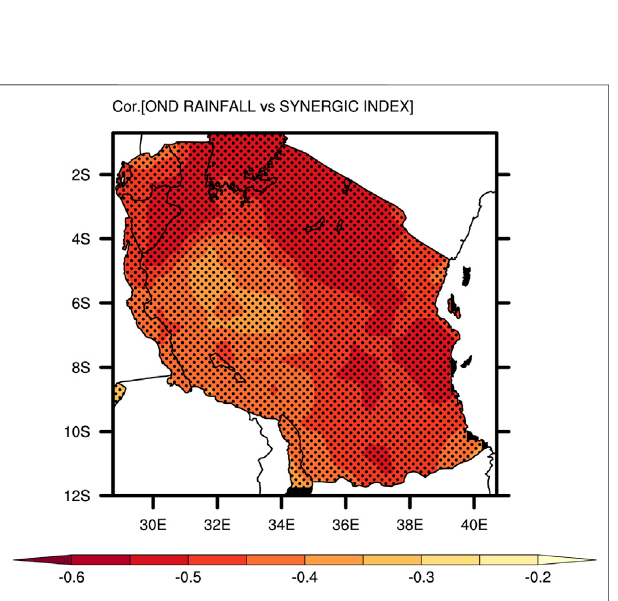
FIGURE 15 | Correlation map of OND rainfall in Tanzania with the synergic index constructed by adding the normalized EA-SST and SA-SST during 1950 – 2017. Regions above the 99% con fi dence level are